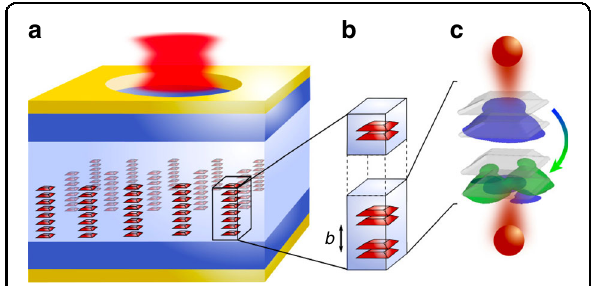
Fig. 10 Scheme of a vertical-cavity surface-emitting QD chain- based QCL. a Electronically coupled QDs form an array of QD chains serving as the QCL ’ s gain material. b QDs separated by tunneling barriers of width b arranged in two-QD unit cells. c Vertical spontaneous emission from transitions between s-type (blue) and p-type (green) QD